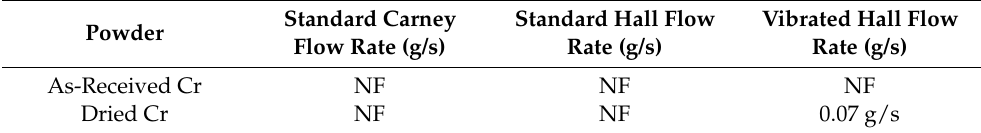
Figure 17. Green body thickness data of impacted green bodies for evaluated Cr powders. Table 8. Standard and modified flowability data for Cr powders.